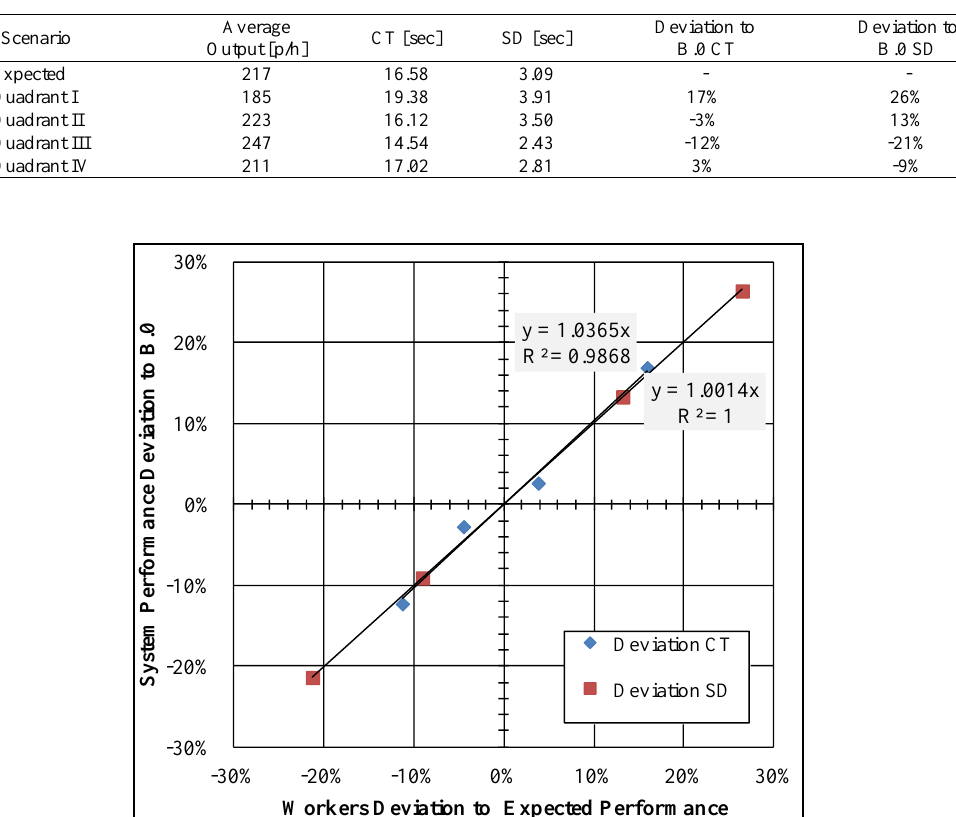
Figure 6. Relation between workers deviation to expected performance and system output for Scenarios B